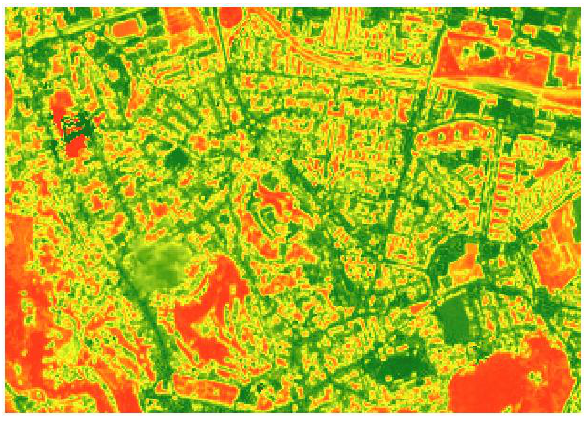
Figure 7 . NDVI for year 2017